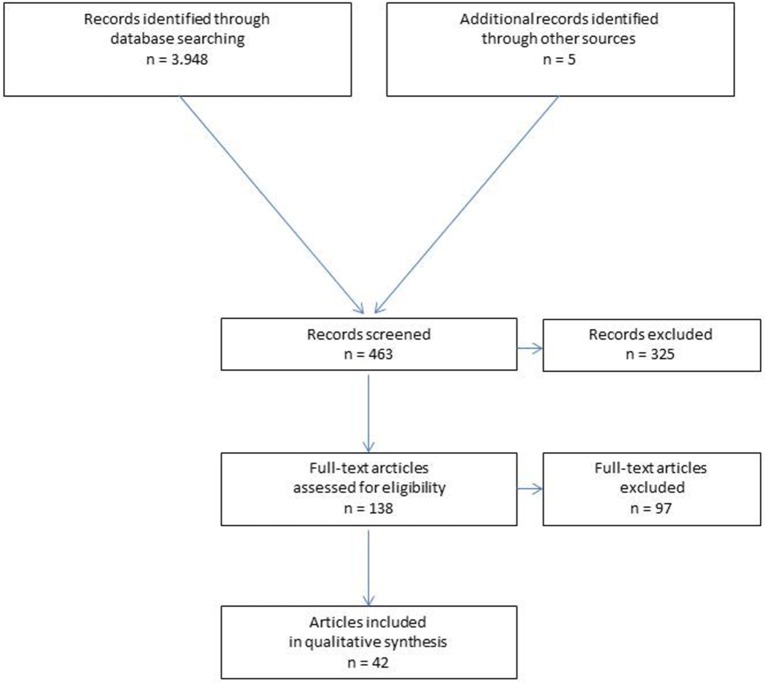
Prisma flow diagram of study inclusion.